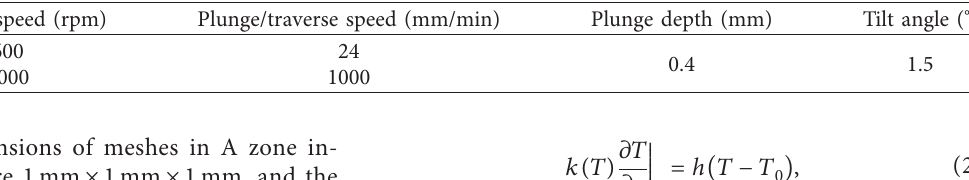
Figure 2: High-speed friction stir welding process. (a) Schematic view; (b) experimental setup. Table 1: Welding parameters in different stages during the FSW